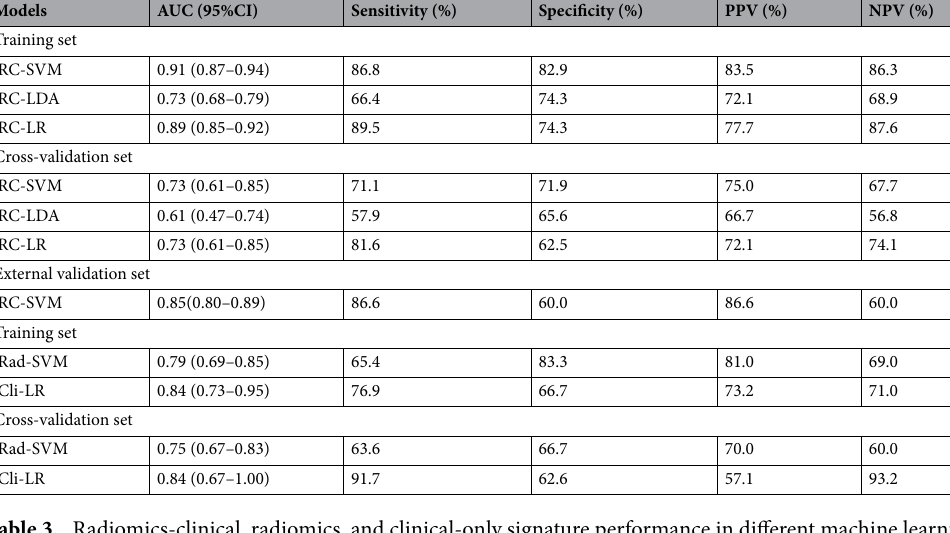
Table 3. Radiomics-clinical, radiomics, and clinical-only signature performance in different machine learning models. RC Radiomics-Clinical, SVM Support Vector Machines, LDA Linear Discriminant Analysis, LR